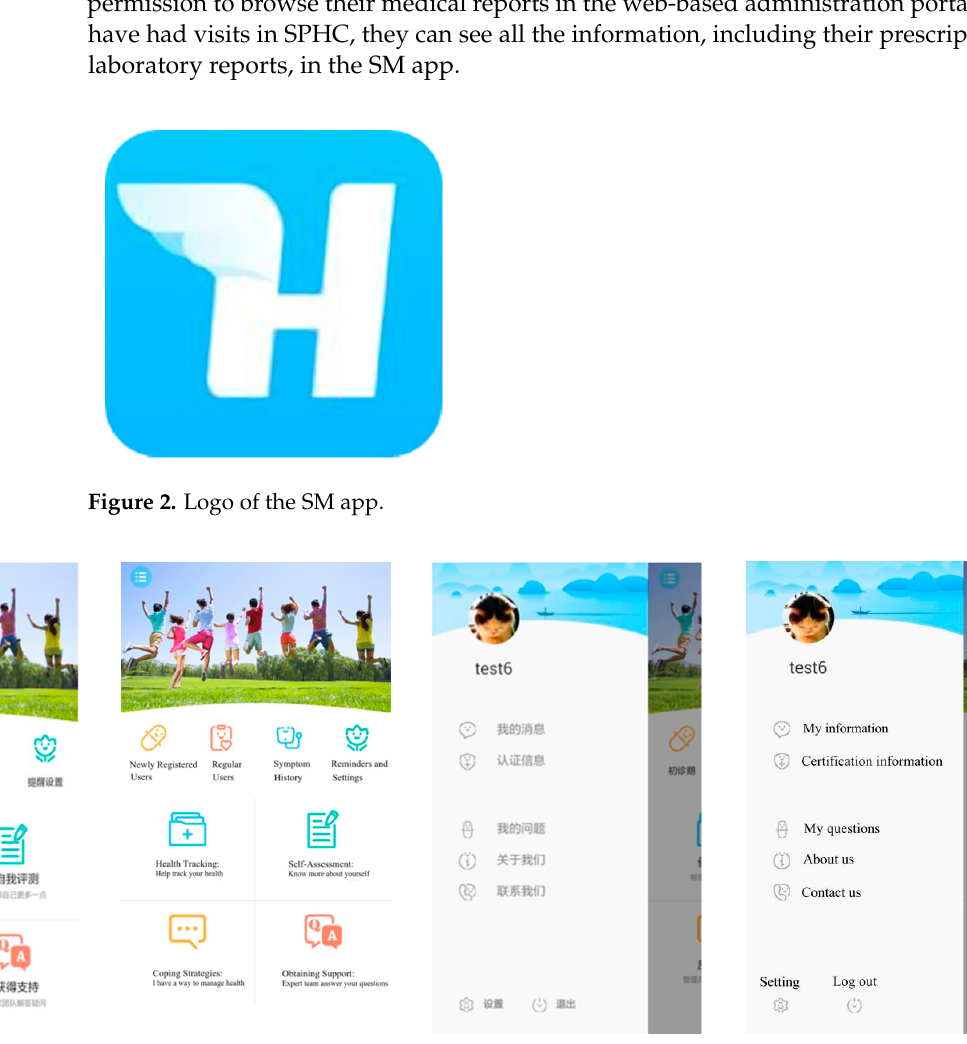
Figure 3. Screenshot of the home page and information settings.